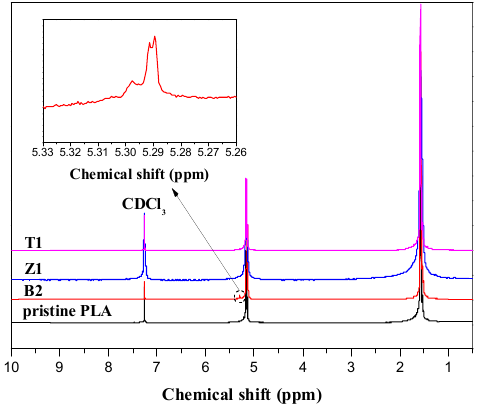
Figure 2. 1 H-NMR spectra of PLA samples.